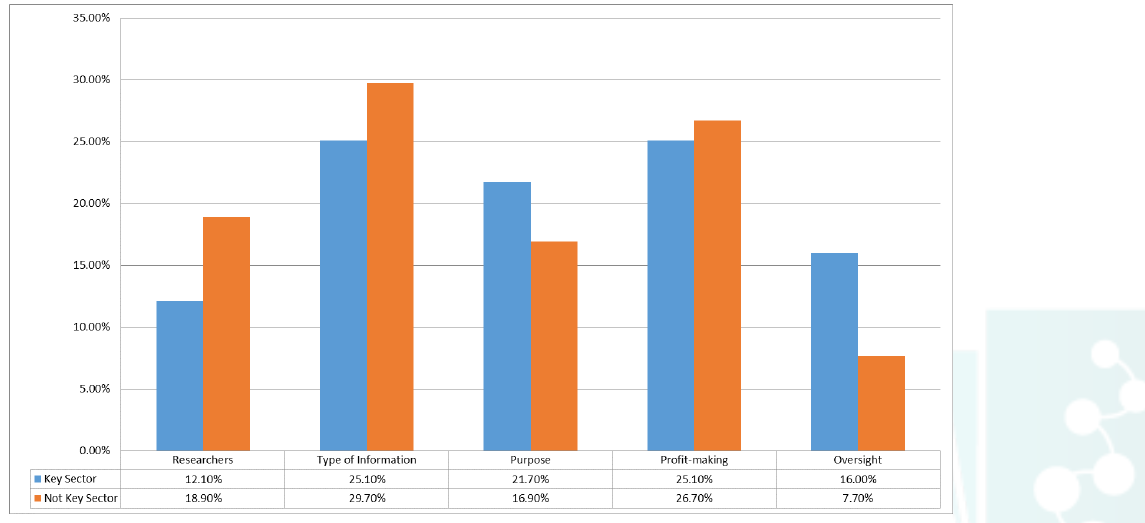
Figure 5: Relative Importance of Attributes for those Working in Key Sectors and Non-Key